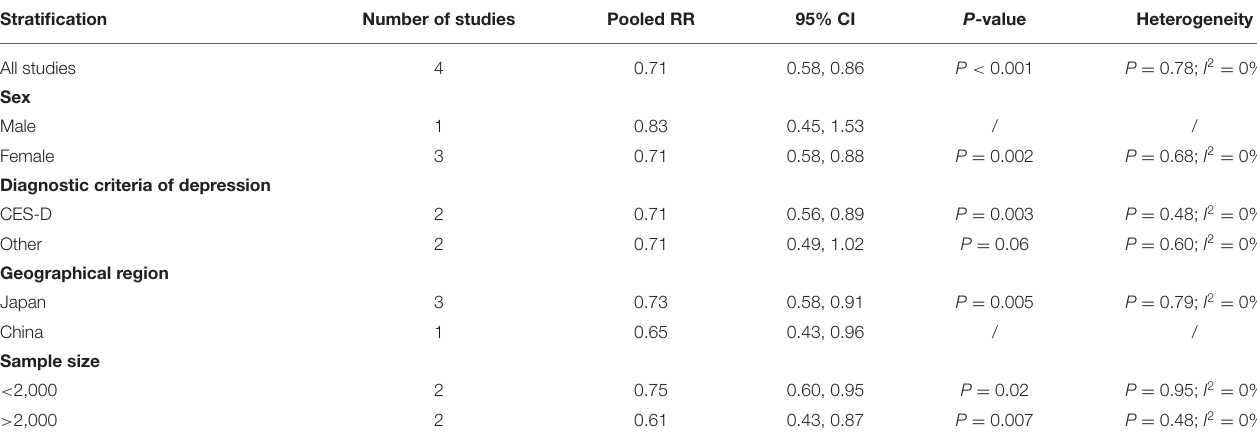
TABLE 4 | Subgroup analysis of depression for the highest vs. lowest dietary manganese intake category.